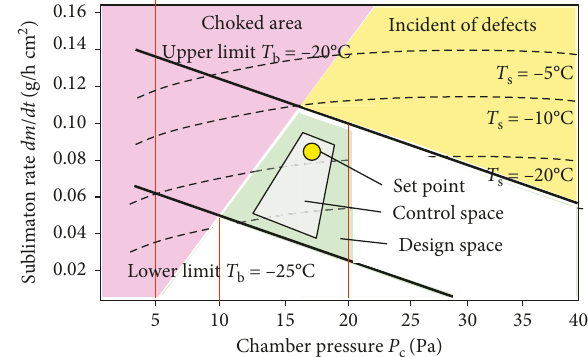
Figure 4: Example of design space. Typical determination method of design space is described in Section